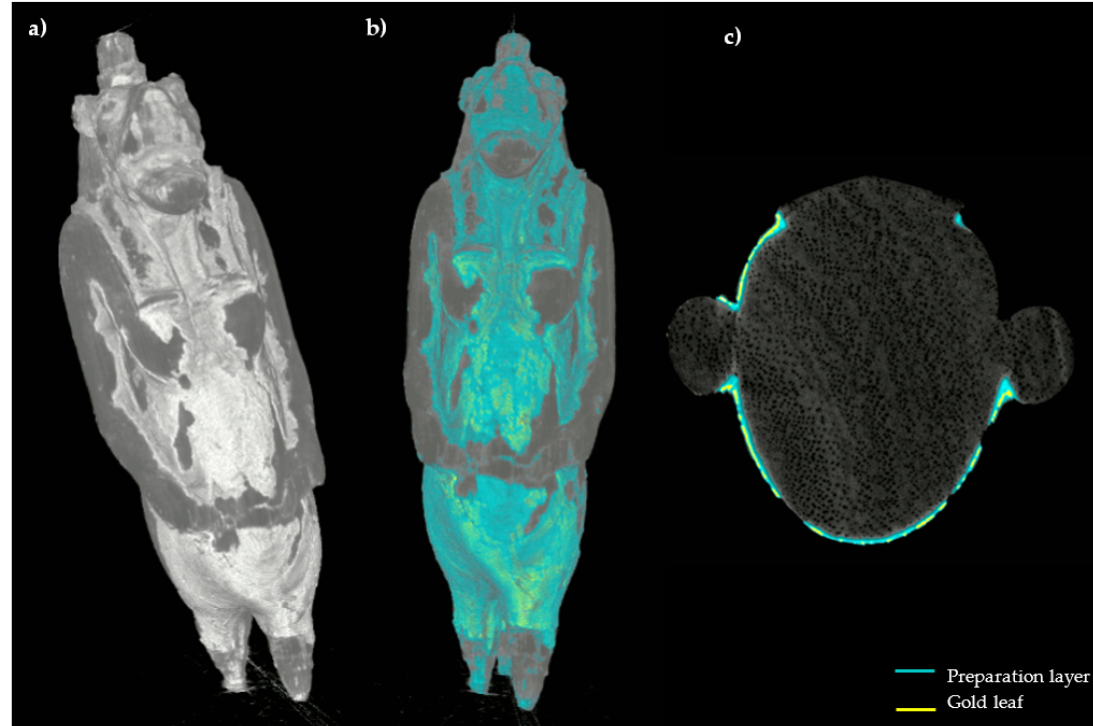
Figure 10. 3D model of the statuette (( a ), Hardware render (scatter gradient) tool) with the segmentation performed on the